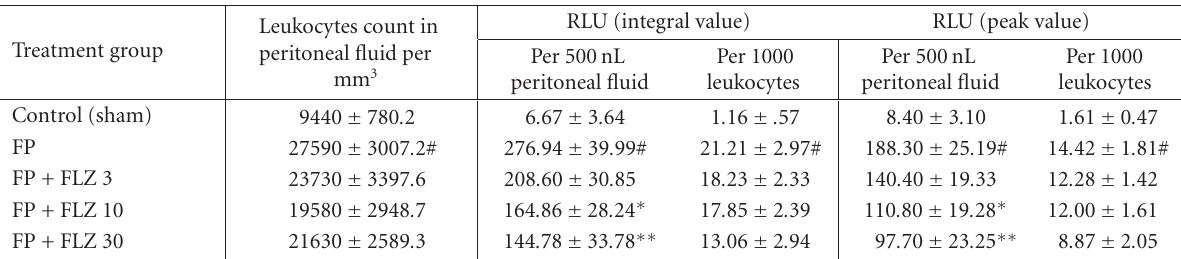
Table 1. E ff ect of fluconazole (FLZ) on luminol-dependent chemiluminescence response of phagocyting leukocytes in the peritoneal fluid of rats with septic